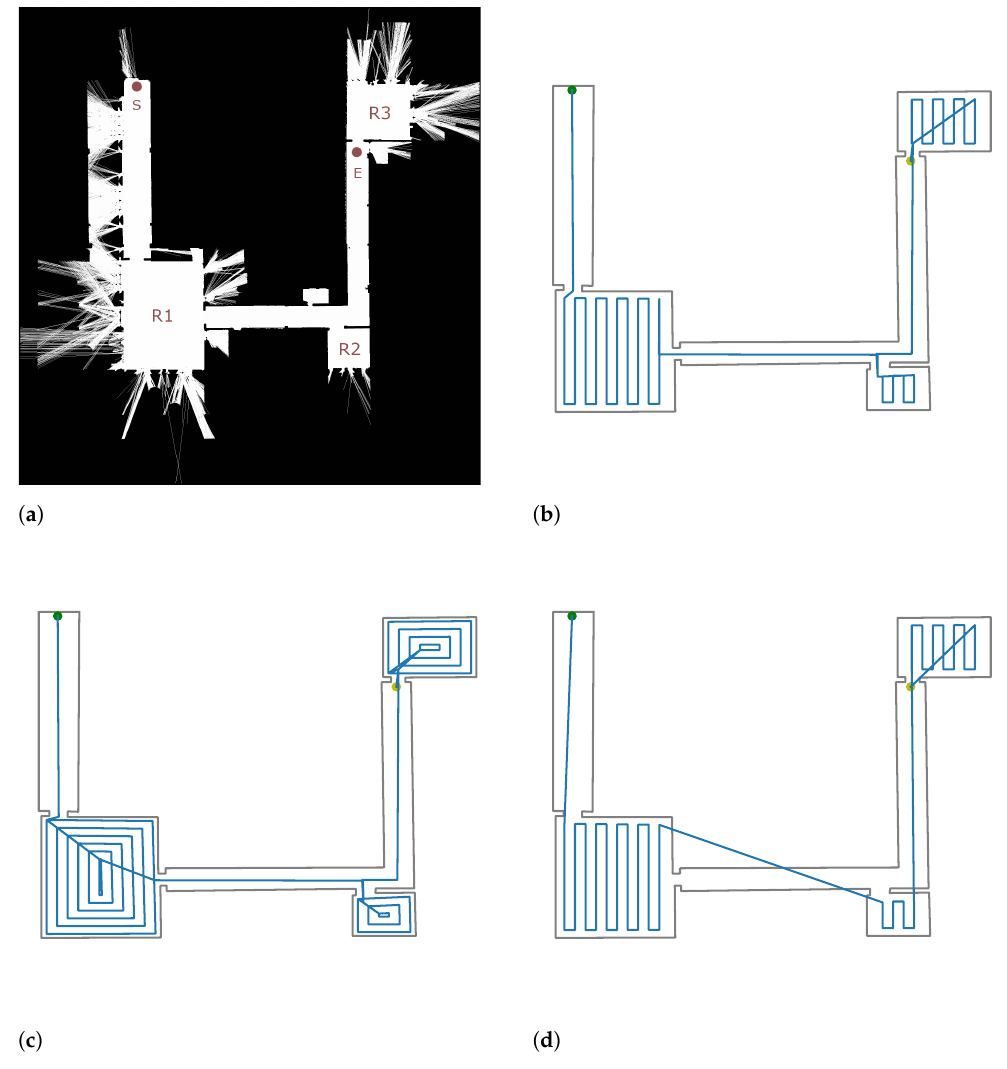
Figure 5. Case study. The map generated after SLAM and the computed coverage paths are displayed. Robot starting point is drawn in green. Ending point is drawn in yellow. ( a ) The 2D initial map. Rooms (R1, R2 and R3), starting point (S) and ending point (E) are specified by the final user. ( b ) Computed path by DnC-RCPP. The map polygon is displayed in grey. The planned route is drawn in blue. ( c ) Computed path by DnC-Contour. The map polygon is displayed in grey. The planned route is drawn in blue. ( d ) Computed path by TSPP [9]. The map polygon is displayed in grey. The planned route is drawn in